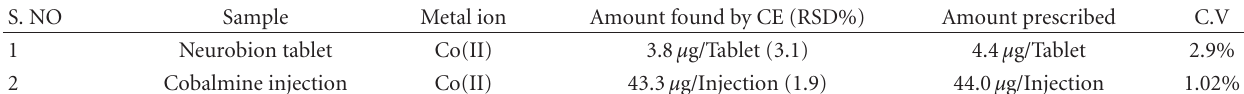
Table 4: Determination of Co(II) in pharmaceutical preparations.